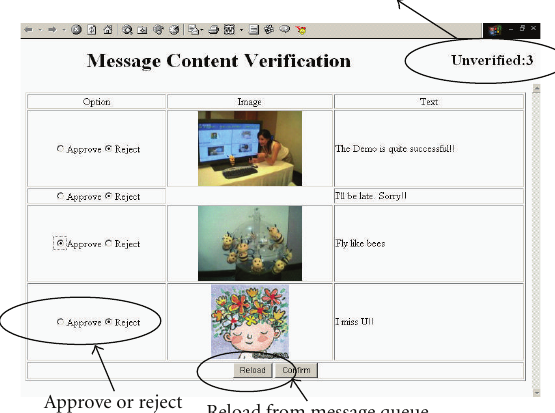
Figure 4: An optional web-based interface to preview